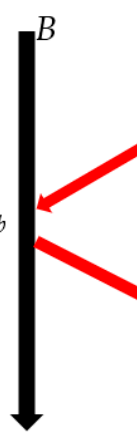
Figure 6. Data points